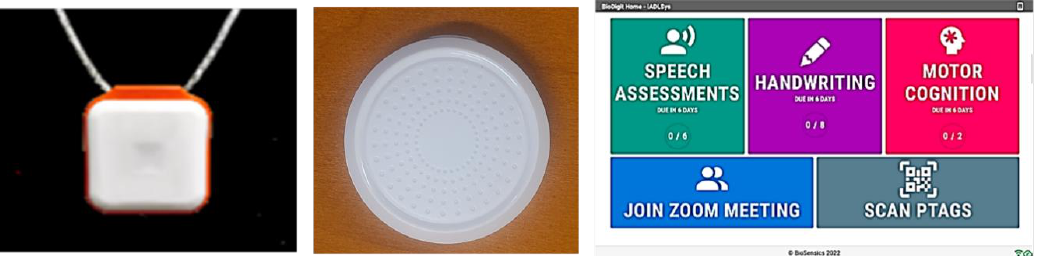
Figure 1. IADLSys: a pendant sensor (PAMSys+, left ); wireless tag (pTAG, middle ); and interaction- tablet PC ( right ).